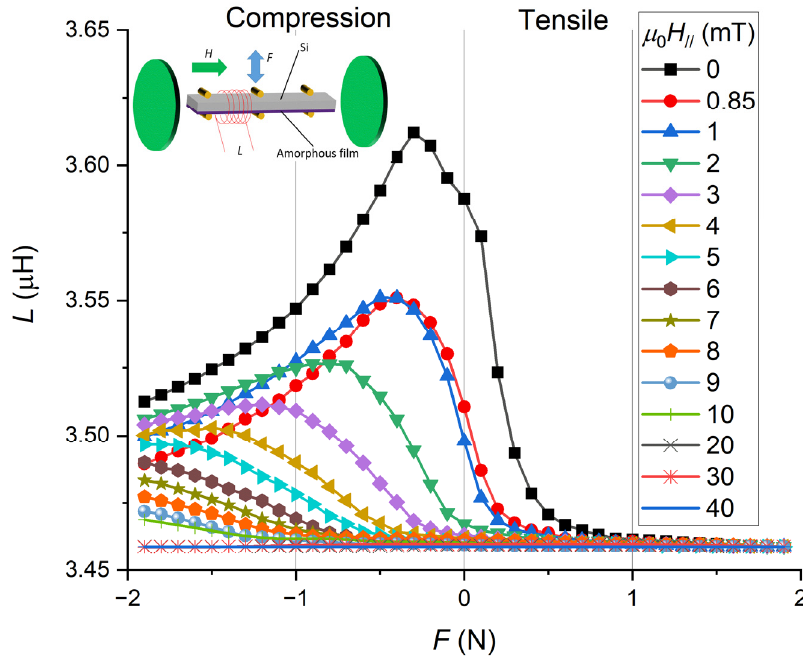
Figure 1. Measurement of the coil inductance versus the applied force with the applied longitudinal field.